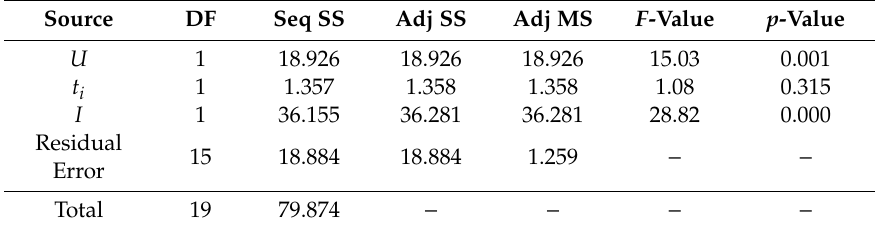
Table 6. ANOVA for the drilling speed ( v ).